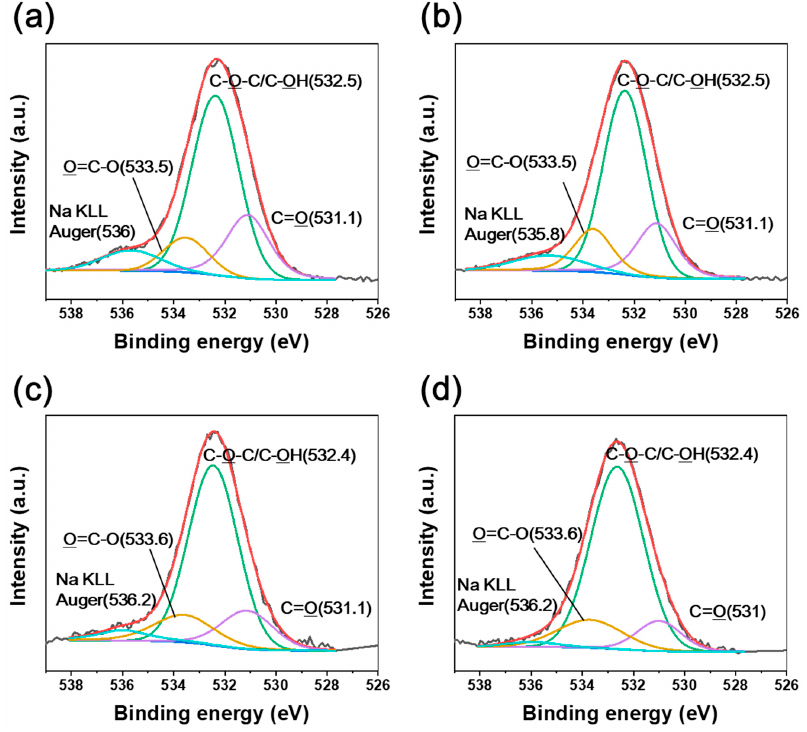
Figure 7. O1s XPS spectra of natural HDPE irradiated at ( a ) 3.4 kGy/s, ( b ) 6.8 kGy/s, ( c ) 13.5 kGy/s, and ( d ) 27 kGy/s absorbed dose rates.